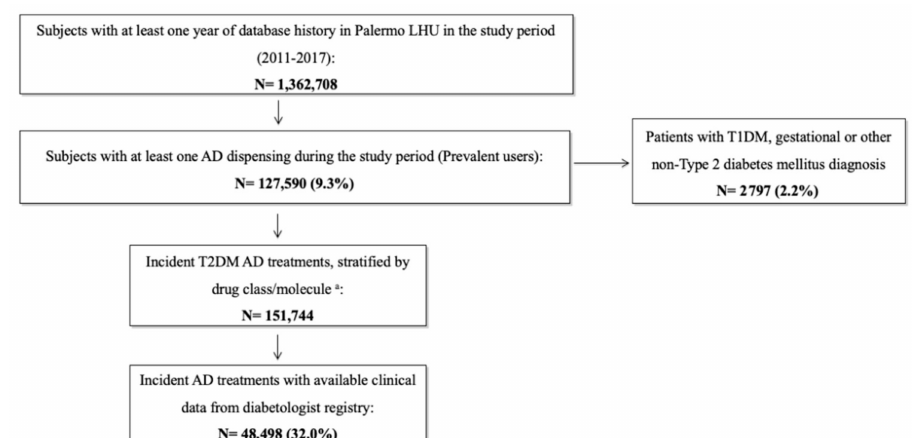
Figure 1. Flow-chart of T2DM patients receiving antidiabetic drugs in Palermo Local Health Unit in the years 2011–2017. Legend: LHU: Local Health Unit; AD: Antidiabetic drug; T1DM: Type 1 diabetes mellitus; T2DM: Type 2 diabetes mellitus. a Subjects without any AD dispensing of the same drug within one year prior to the treatment start date, i.e., index date (ID). The same patient could be included in di ff erent AD classes; for this reason, incident T2DM AD treatments were more numerous than prevalent users.